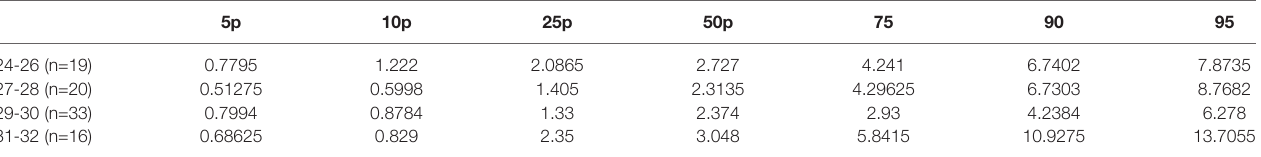
TABLE 5 | Distribution of TSH (mU/l) values in preterm infants born <33 weeks GA, measured at 2 weeks